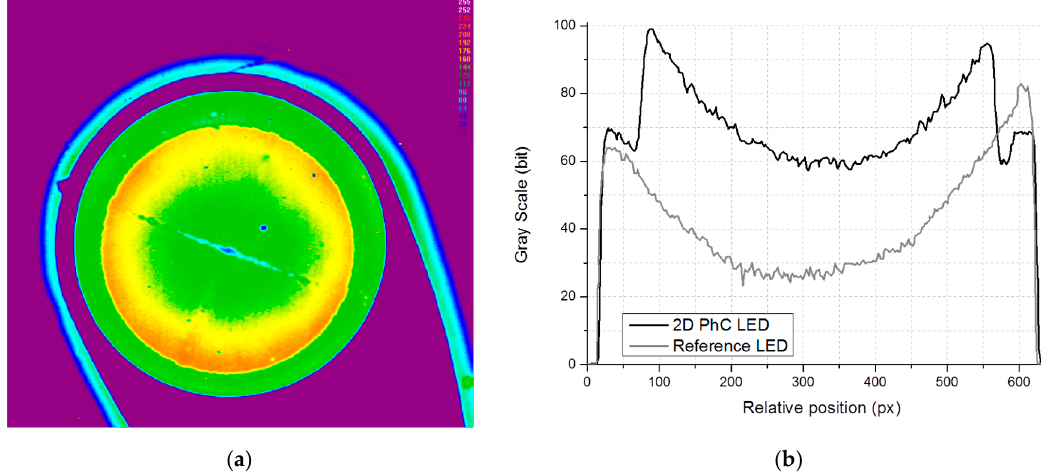
Figure 10. ( a ) Intensity image of surface emission LED with 2D PhC structure and ( b ) its profile compared with reference LED.